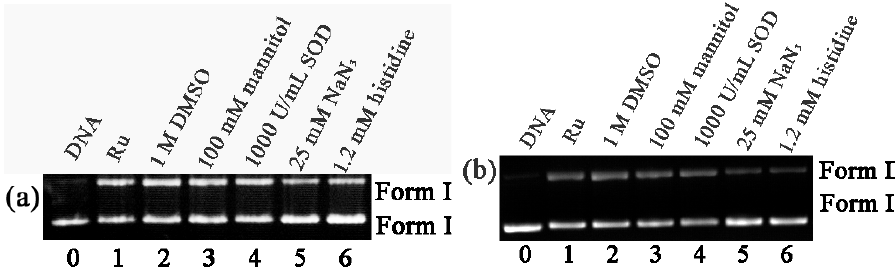
Figure 6. Photoinduced cleavage of pBR322 DNA incubating different scavengers after 2 h irradiation for 1 ( a ) and 2 ( b ) (30 µ M).